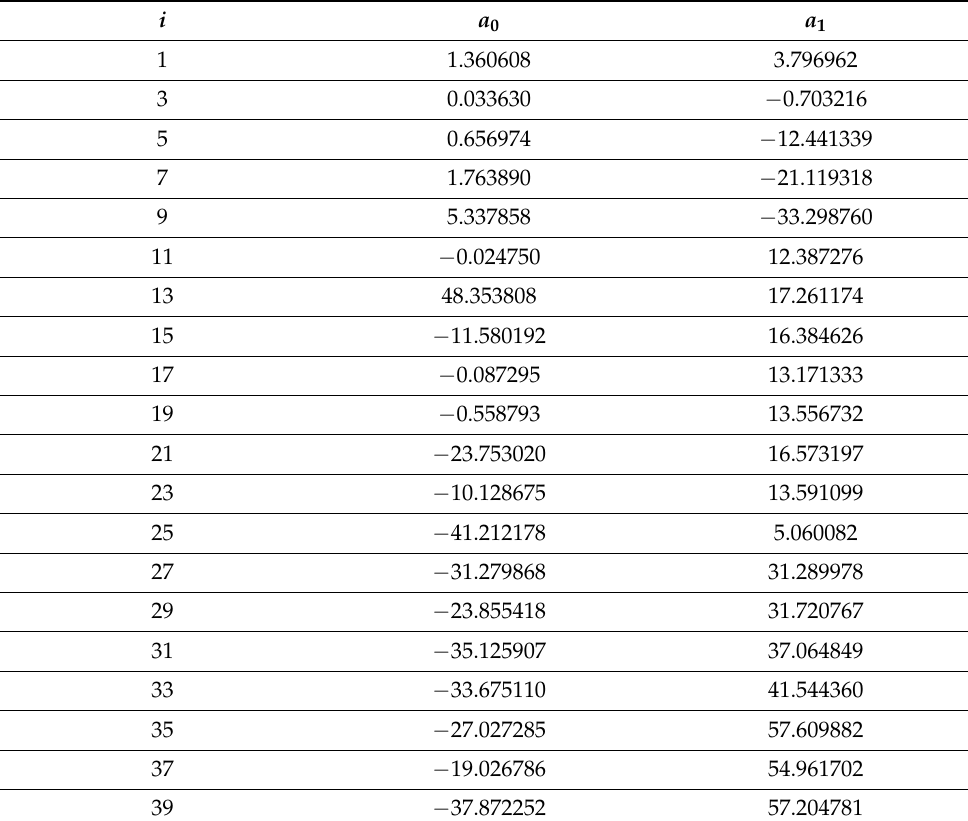
Table 2. Activity model for CH 4 dissolved in